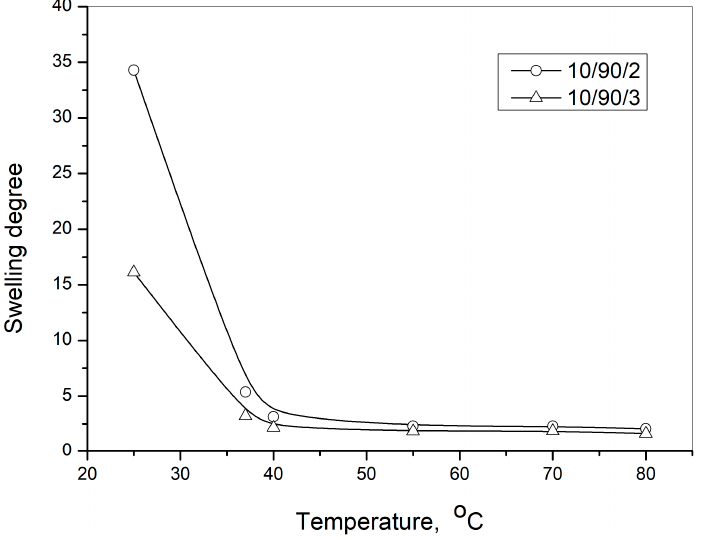
Figure 6. Dependence of the degree of swelling on time of p(NiPMAm/NiPAm) hydrogels in the solution which pH value is 7.4 at the temperature: ( a ) 25 °C and ( b ) 37 °C.